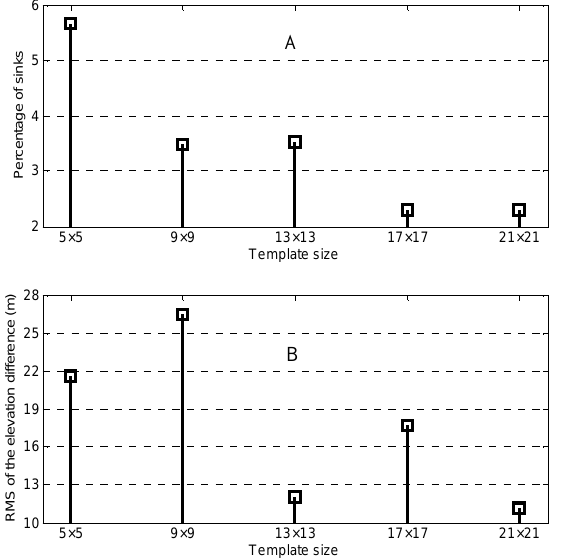
Figure 4. Percentage of sinks (A) and RMS of the difference of elevation between filled and unfilled DEM